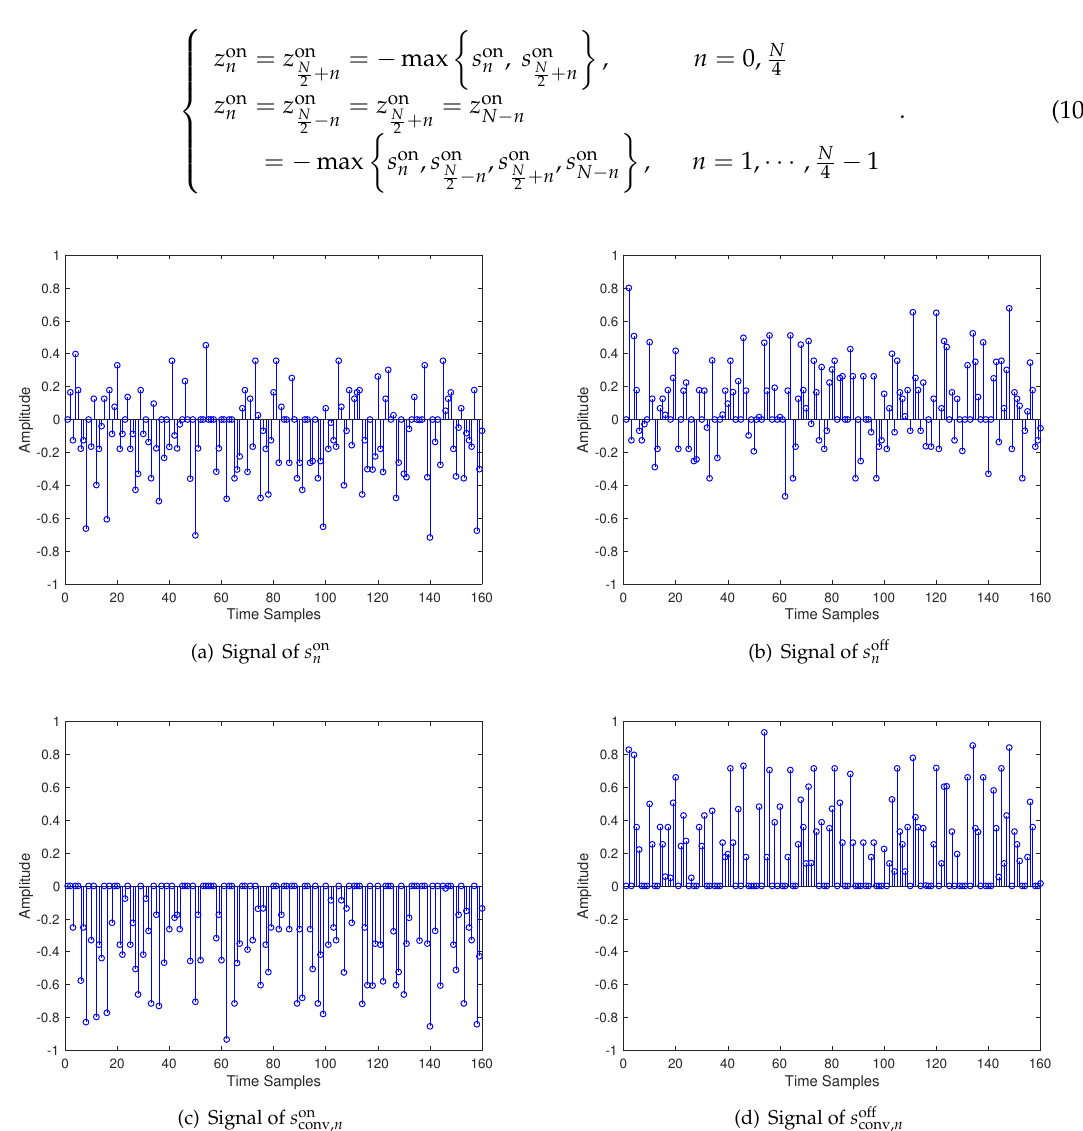
Figure 2. A demonstration of the superposed signal in DCHO-OFDM. ( a , b ) depict the bipolar signal s on n and s off n , where the ACO-OFDM signal is directly combined with upper/down-clipped PAM-DMT; ( c , d ) present the unipolar signal of s on conv, n and s off conv, n , aided by the introduced time-varying biasing